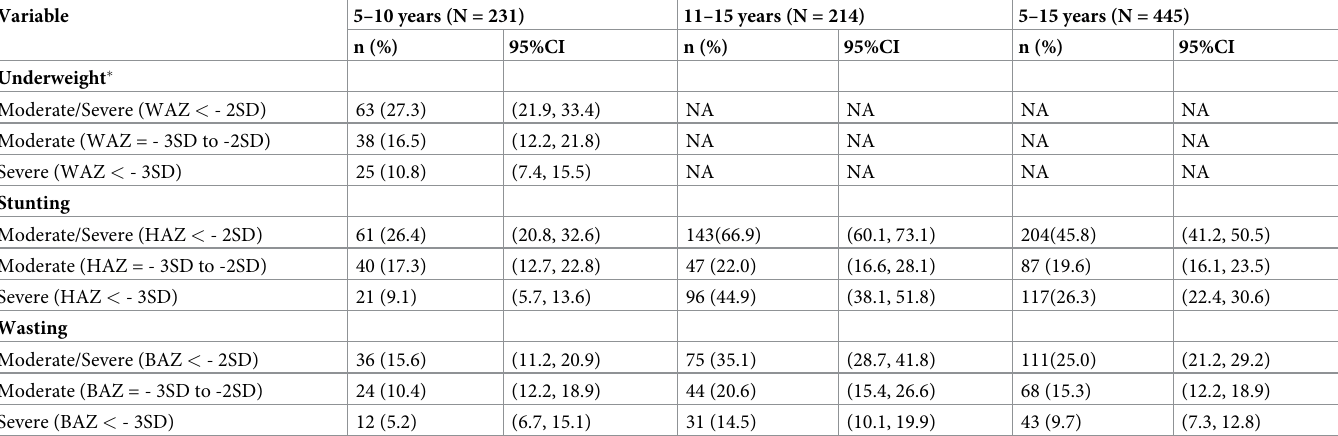
Table 4. Prevalence of underweight, stunting and wasting among schoolchildren in Sana’a Governorate, Yemen �